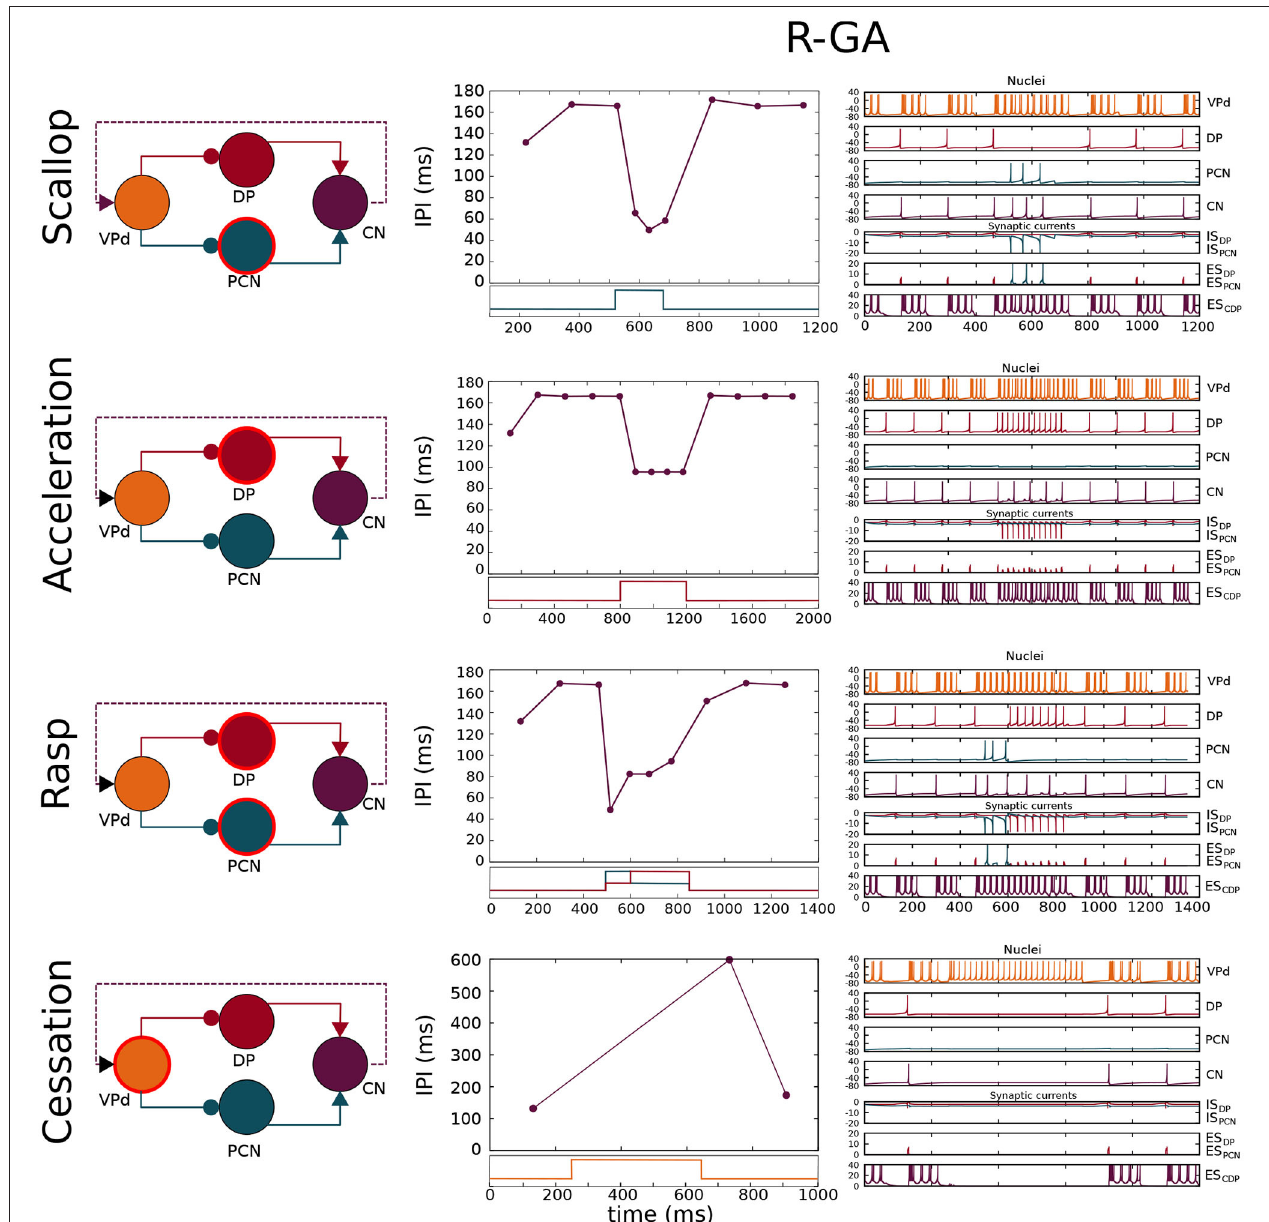
FIGURE 4 | Simulation of the four SPI patterns in the configuration adjusted to patterns recorded from freely-behaving G. petersii specimens (R-GA). Each row shows a schematic of the network where the nucleus/nuclei responsible for generating the SPI (Caputi et al., 2005) is/are highlighted using a circular red stroke. The results are depicted in two columns: the first one shows SPIs resulting from the simulation, and the second one shows the nuclei voltages and synaptic currents. Each chart is related to its corresponding nuclei/synapse by color. Step functions used as current inputs to activate nuclei/nucleus are depicted under each SPI pattern, and they are also related to their corresponding nuclei by color. Relevant model parameters optimized by the GA are described in Table 1 . Simulation parameters used in the simulations are described in Supplementary Section 3 .